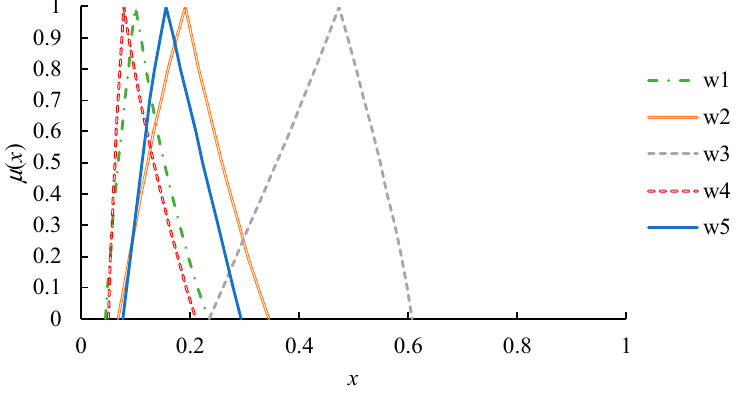
Figure 8. Values of fuzzy priorities derived using ACO.